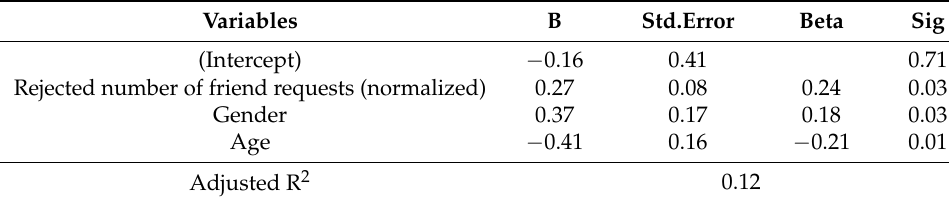
Figure 3. Interaction effect of gender homogeneity and age on cognitive depression (marginal models).